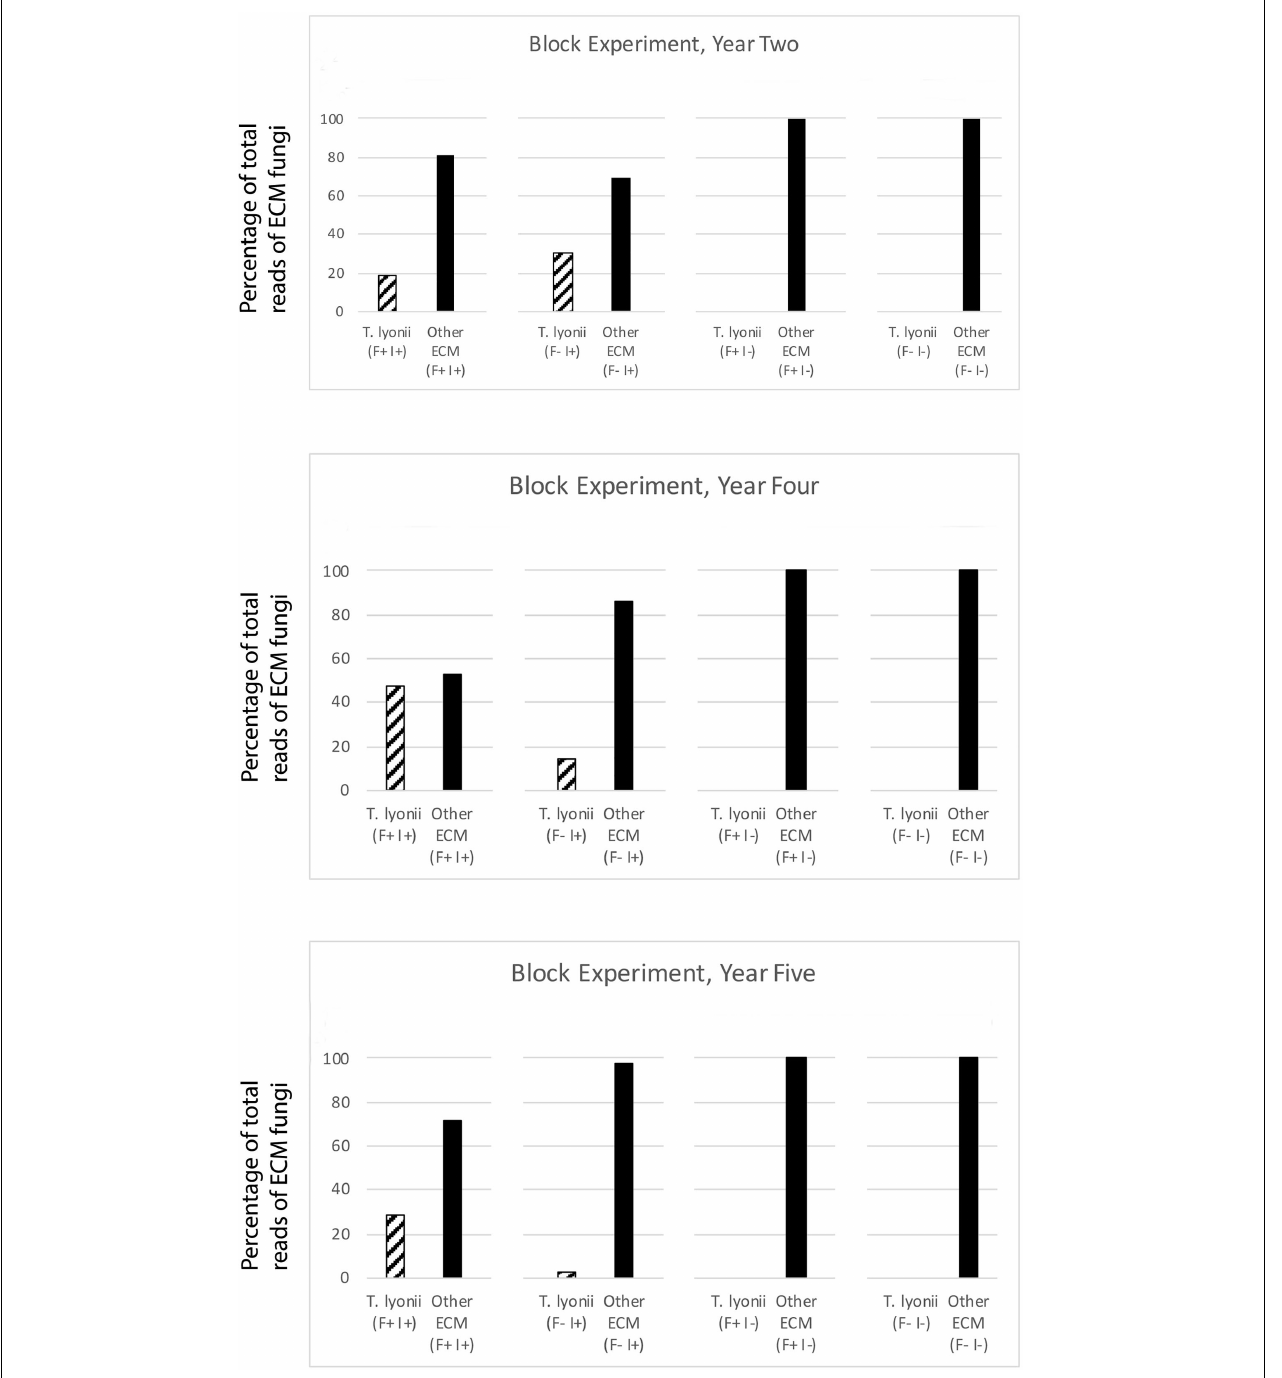
FIGURE 4 | Results of the fumigation and inoculation block experiment at Tift for year 2, 4, and 5. This figure depicts the percentage of total sequence reads that were from T. lyonii versus all other ECM fungi in each of the different treatments: fumigation and inoculation (F+, I+), fumigation and no inoculation (F+, I–), no fumigation and inoculation (F–, I+), and no fumigation and no inoculation (F–,